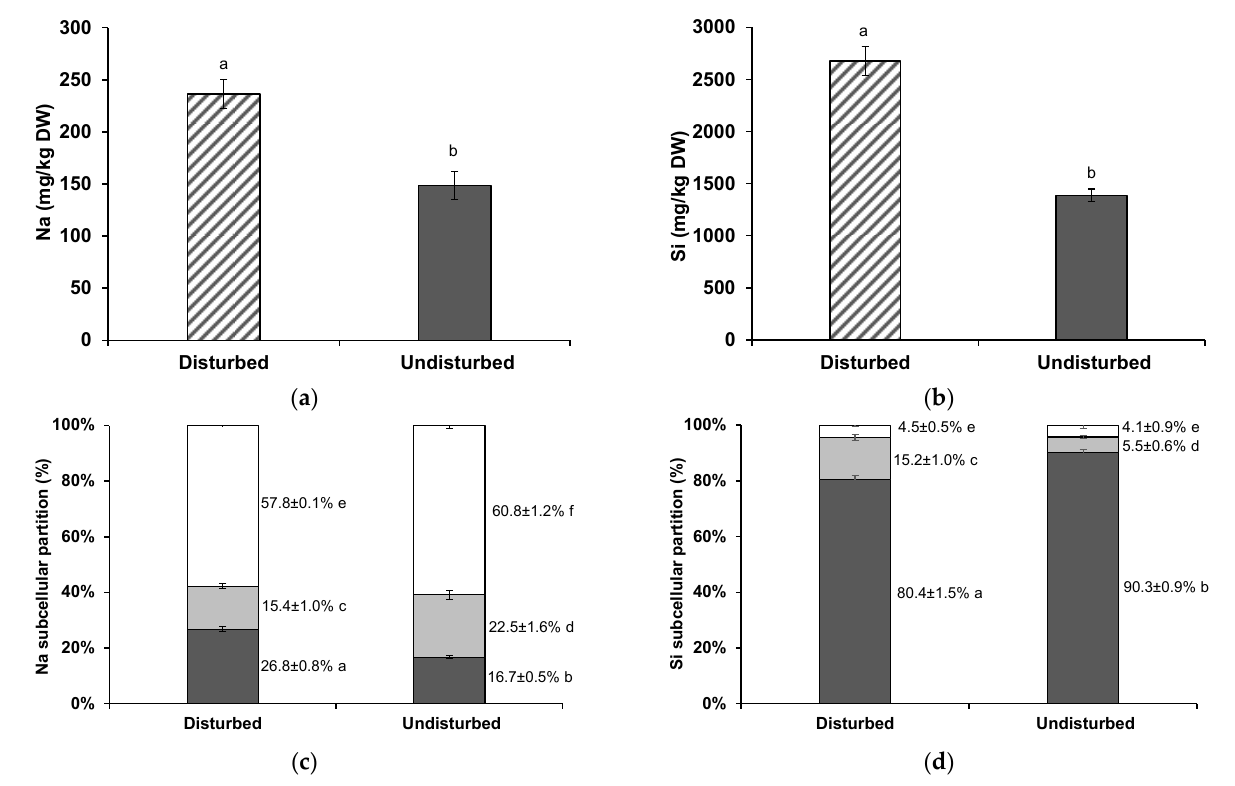
Figure 4. Concentration (average and standard error) of Na ( a ) and Si ( b ) in the shoots of wheat plants grown in disturbed (striped columns) or undisturbed (grey columns) acidic soil, after Ornithopus compressus growth. The proportions (average and standard error) in the cell wall fraction (dark grey columns), organelle fraction (light grey columns), and vacuole contents fraction (white columns) were also determined for Na ( c ) and Si ( d ). Values next to bars are the element percentages for each fraction. Different letters indicate statistically significant differences ( p < 0.05).